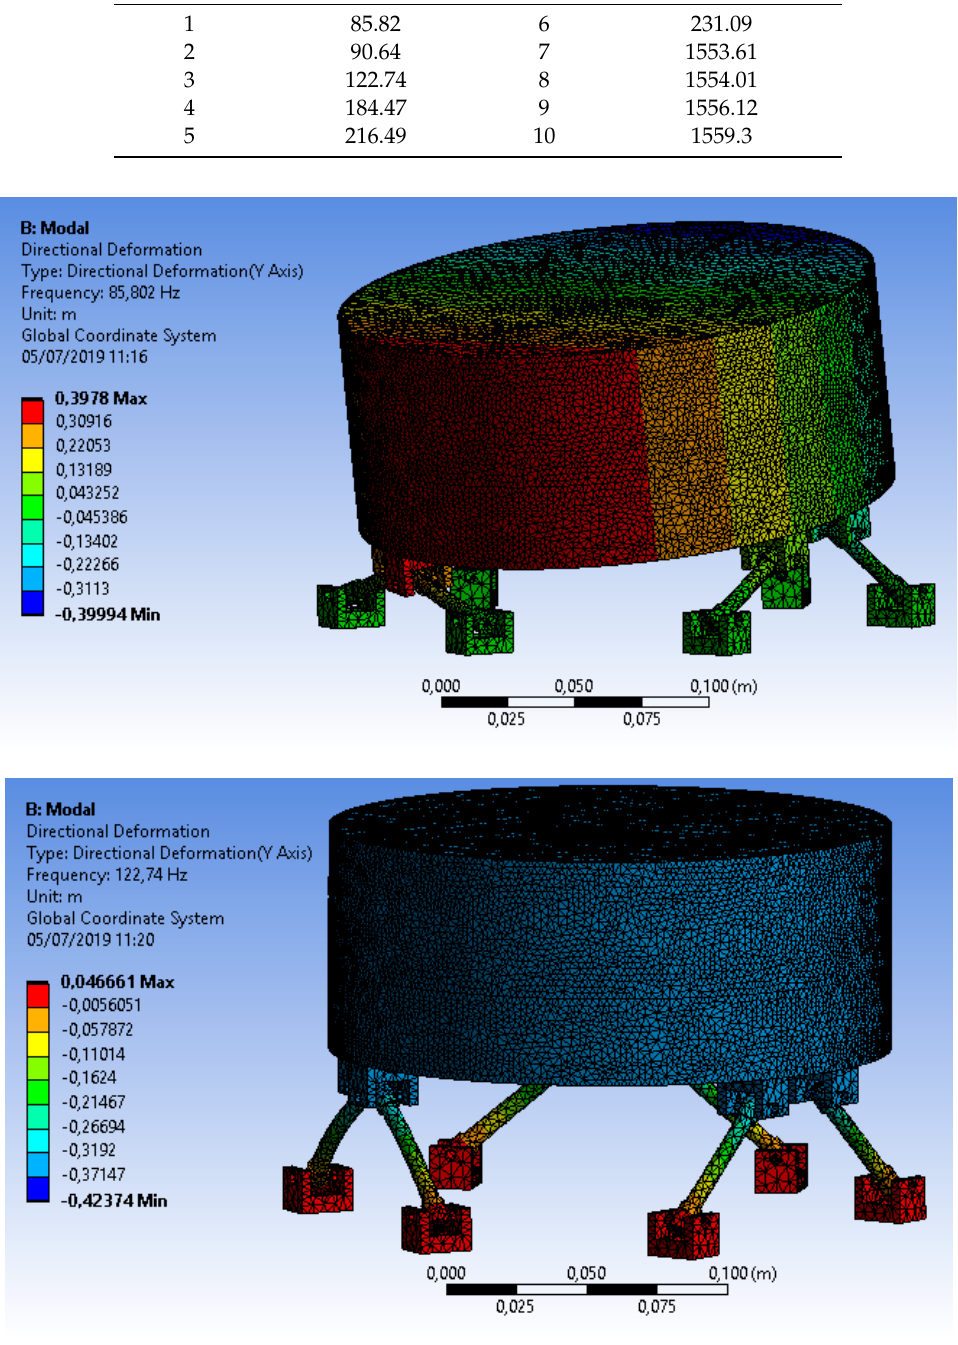
Figure 10. Vertical deformation of the first ( top ) and third ( bottom ) vibrational modes. The third mode is the most relevant for vertical deformations.